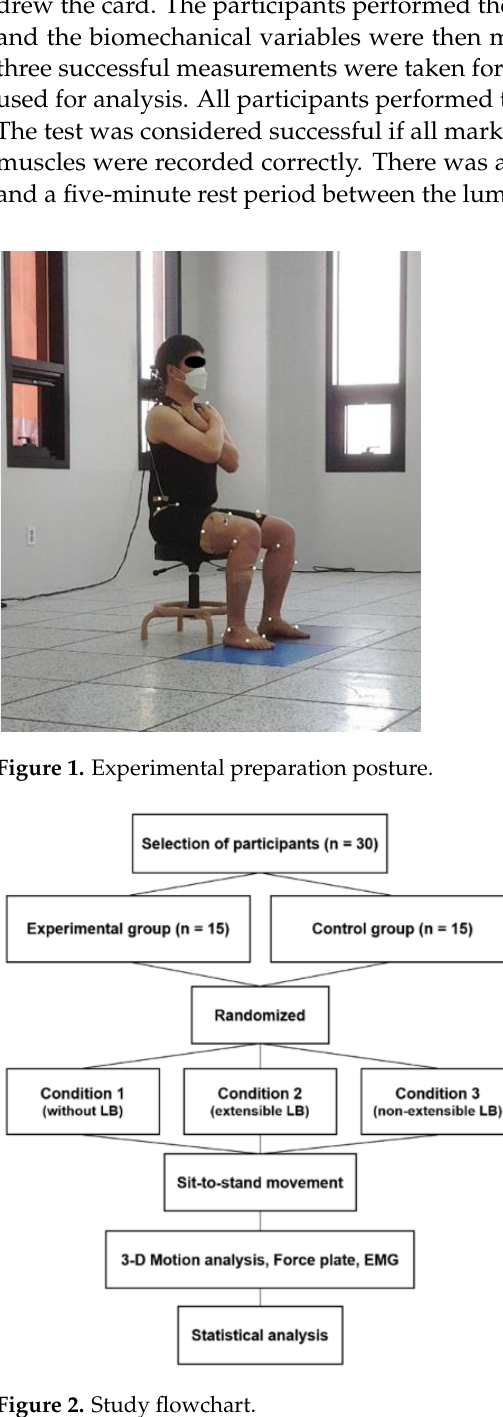
Figure 2. Study flowchart.